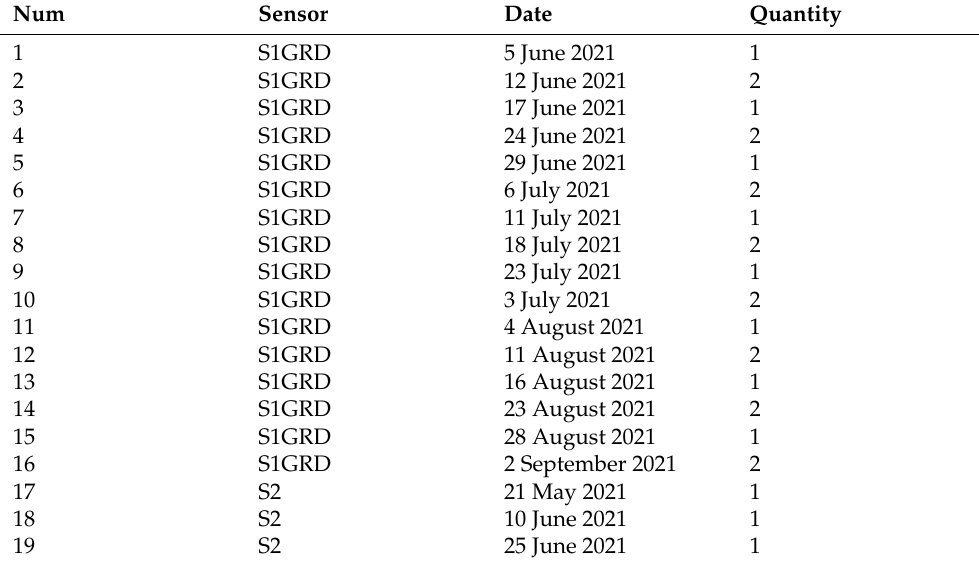
Table 2. Sentinel images used in this